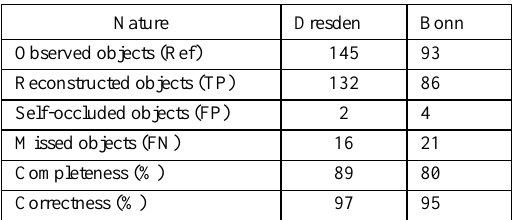
Table 1: Evaluation of façade object reconstruction Nature